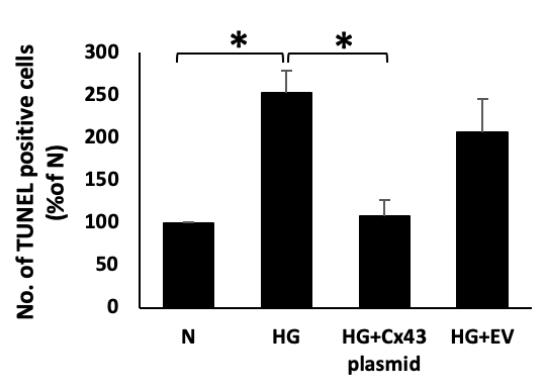
Figure 6. Effect of Cx43 overexpression on apoptosis. ( A ) Representative photomicrographs show a significant increase in the number of TUNEL positive cells (white arrows) in RRECs grown in HG medium compared to those grown in N medium. The cells grown in HG medium and transfected with Cx43 plasmid showed reduced TUNEL positive cells (white arrows) compared to those grown in HG medium. Merged panel shows DAPI stained cells superimposed with TUNEL-positive cells. Scale bar = 100 µ m. ( B ) Bar graph shows cumulative data obtained from five experiments. Data are presented as mean ± SD, (* p < 0.05; n =